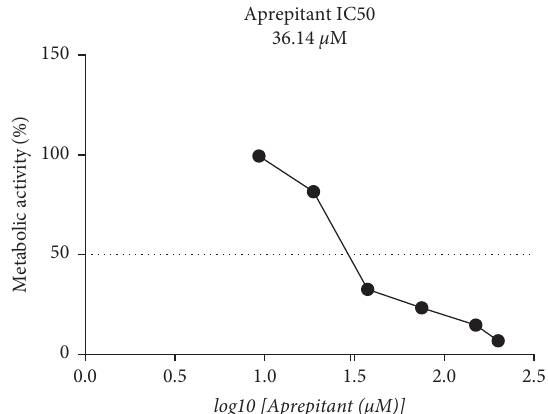
Figure 1: The results of resazurin-based cell viability assay in U87 glioblastoma cells at increasing concentrations (5–100 μ M) of aprepitant for 24h. The IC50 value of about 36.14 μ M was observed for aprepitant in this cell line. Data show the mean ± standard deviation (SD) of three distinct experiments.